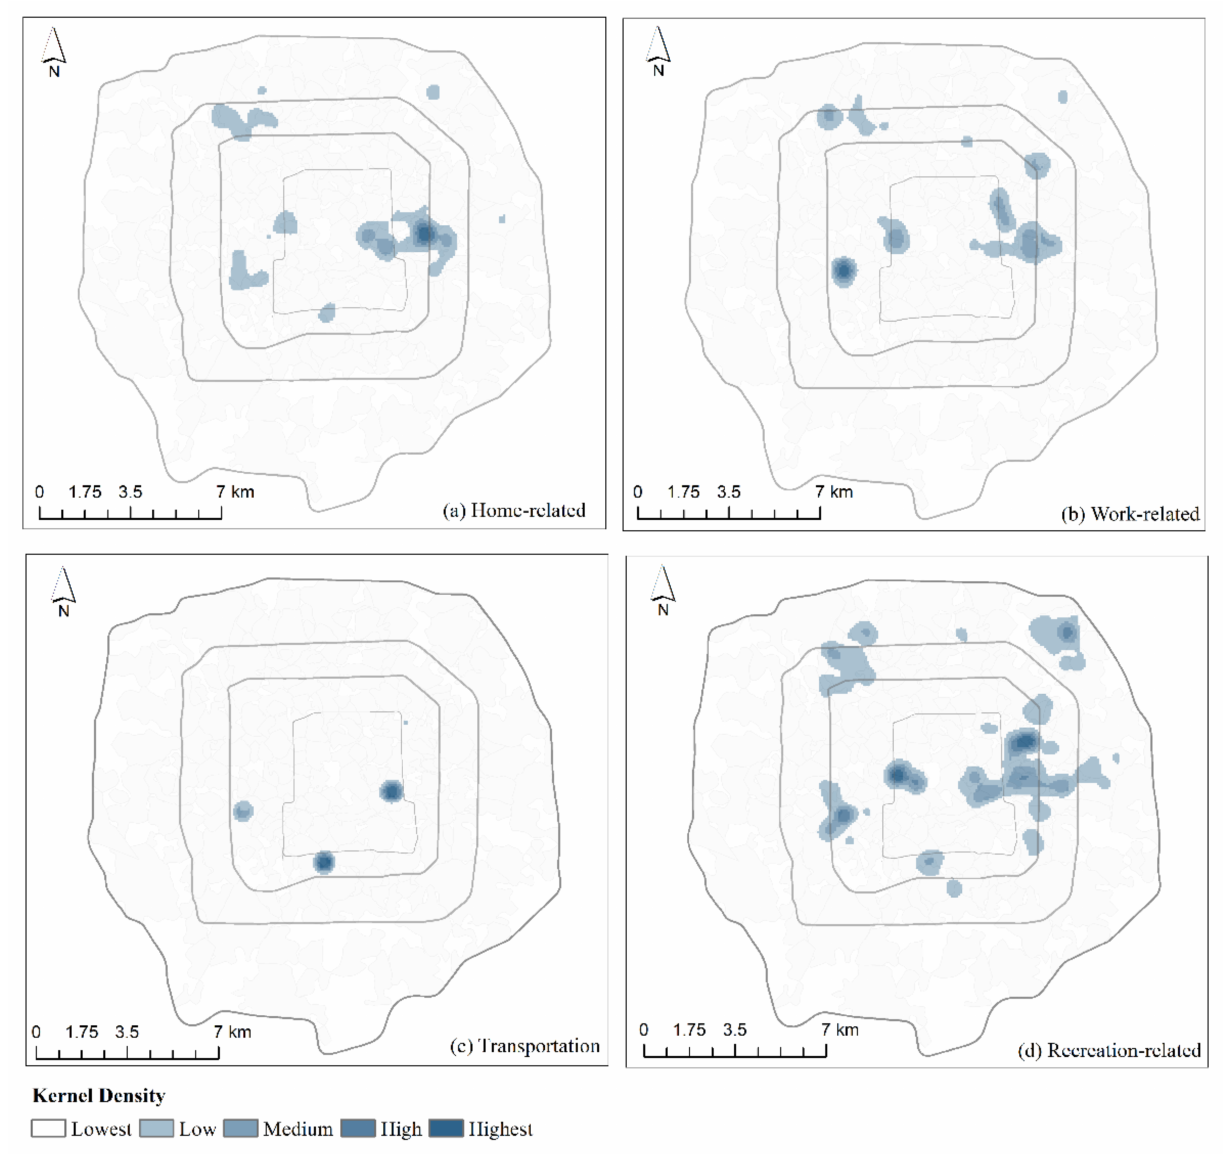
Figure 8. The spatial distribution of different travel activities